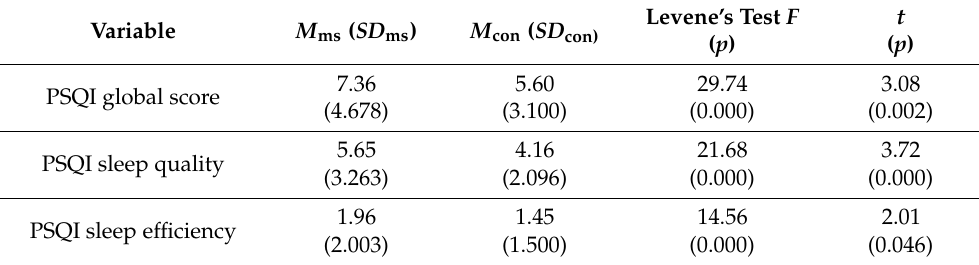
Table 6. Differences in PSQI scores between pwMS (ms, n = 82–87) and the control group (con, n = 133–134).